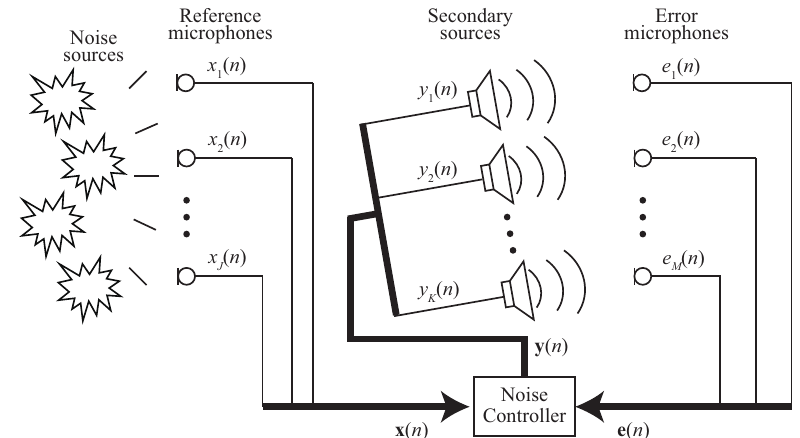
Figure 2. Structure of multichannel feedforward ANC system with J reference microphones, K secondary sources, and M error microphones.